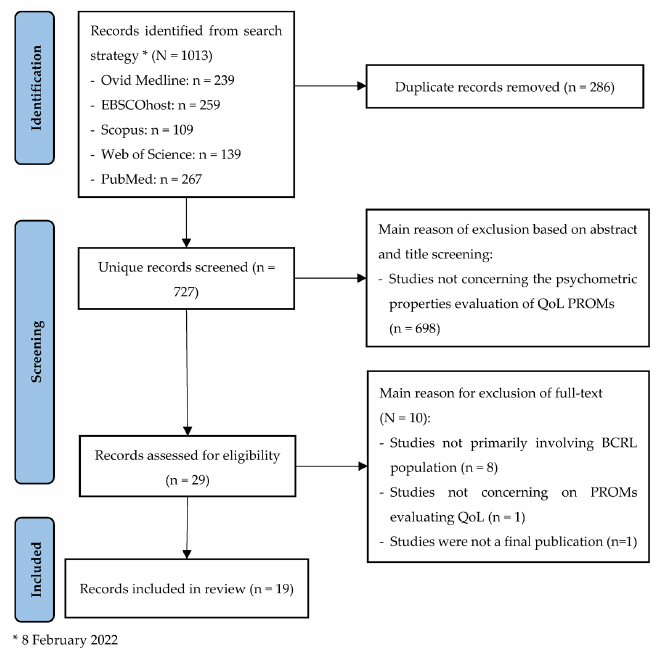
Figure 1. PRISMA flowchart on the study selection process.